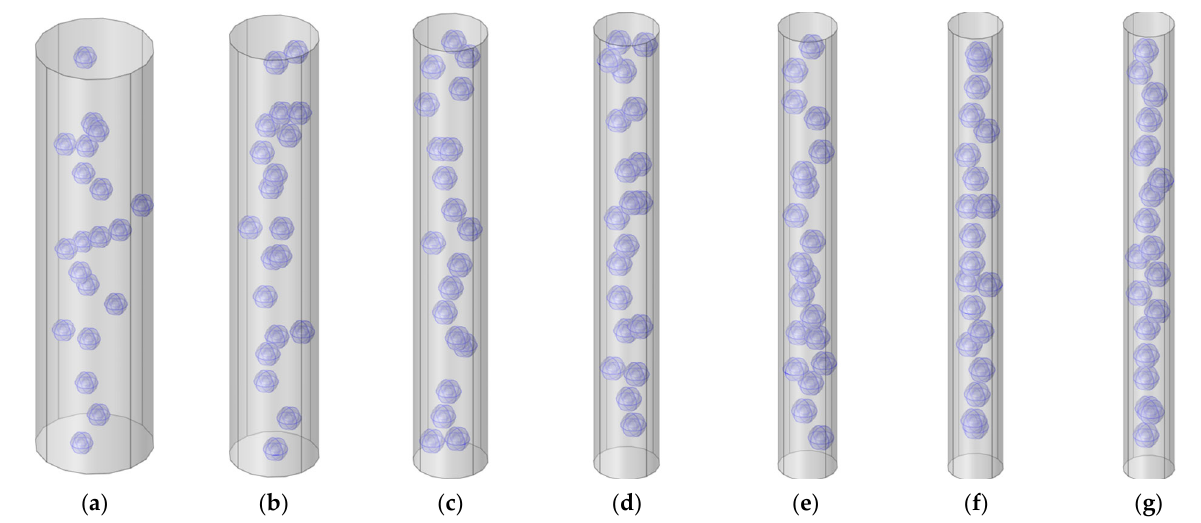
Figure 8. Acoustic finite element simulation models of composite rubber reinforced with HGM for various volume ratio of HGM. ( a ) 2.5%; ( b ) 5.0%; ( c ) 7.5%; ( d ) 10.0%; ( e ) 12.5%; ( f ) 15.0%; ( g ) 17.0%.